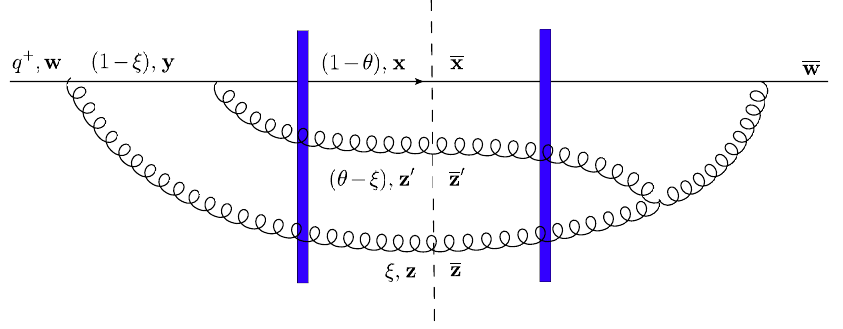
Figure 11 . A particular graph contributing to the “interference” cross-section (3.52); its colour structure is exhibited in eq.